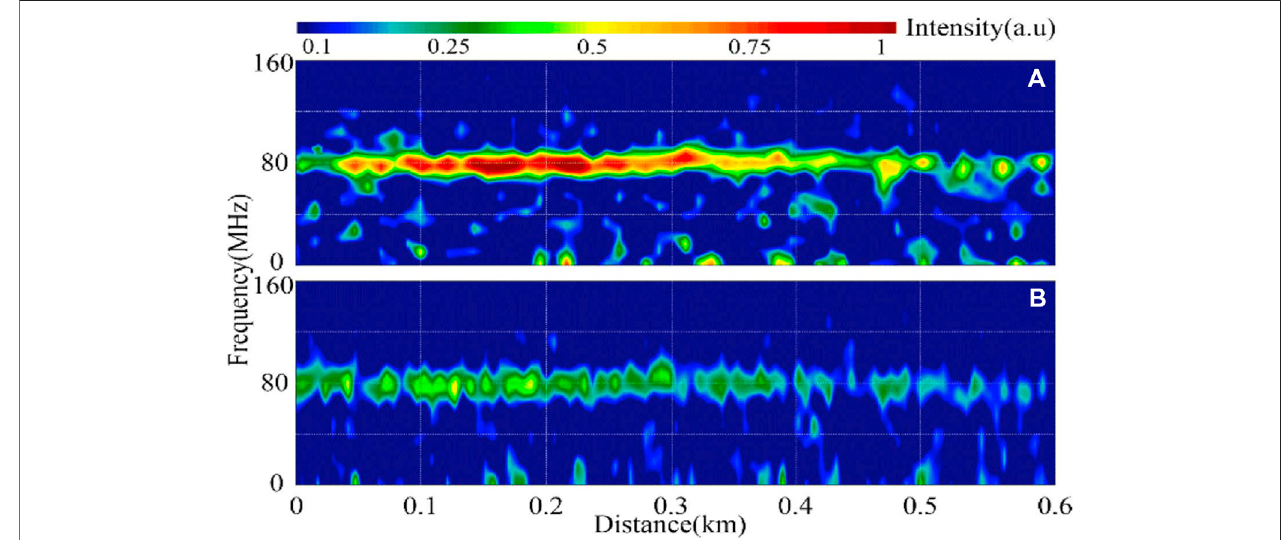
FIGURE 5 | Power spectra distribution of (A) non-coding coherent Doppler wind lidar (C-DWL) and (B) Golay coding C-DWL.